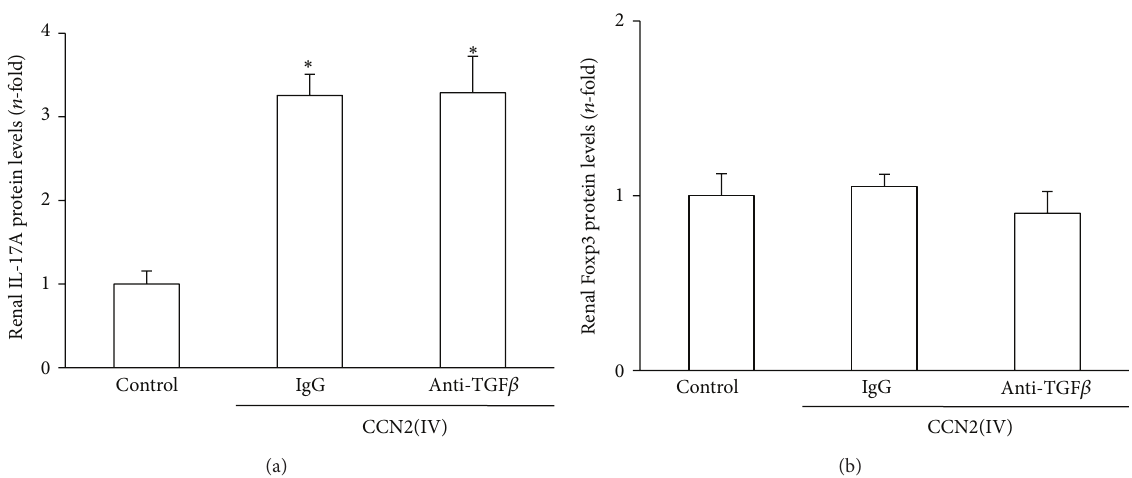
Figure 4: Effect of TGF- 𝛽 blockade on renal Th17/Treg responses modulated by CCN2(IV). The main markers for Th17 or Treg were evaluated in renal total protein extracts. (a) Renal levels of IL-17A were evaluated by ELISA. (b) Foxp3 renal levels were analysed by western blot. Data is shown as ratio of renal Foxp3/GAPDH protein. Mean ± SEM of 10 mice per group and representative western blot experiment. ∗ 𝑃 < 0.05 versus